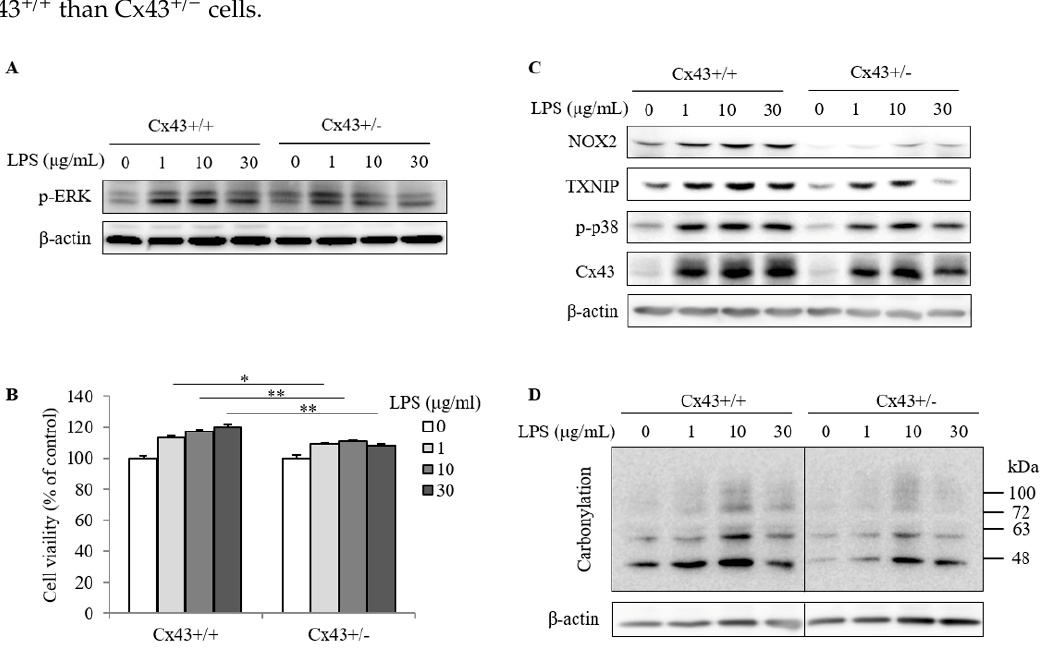
Figure 4. Responses of Cx43 +/+ and Cx43 +/ − spleen cells to LPS-induced changes in proliferation and redox status. ( A , B ) Different cell responses to LPS-induced ERK activation and cell proliferation. Spleen cells isolated from Cx43 +/+ and Cx43 +/ − mice were stimulated with the indicated concentrations of LPS for 24 h. Cell lysates were collected and detected for p-ERK using Western blot analysis ( A ). Cell proliferation after the stimulation was determined using WST assay ( B ). Data are expressed as the percentage of formazan formation against the untreated control (mean ± SE, n = 4). * p < 0.05, ** p < 0.01. ( C ) The response of Cx43 +/+ and Cx43 +/ − spleen cells to LPS-induced changes in intracellular oxidative status. Spleen cells were treated the same as above. The cellular proteins were harvested and subjected to Western blot analysis for NOX2, TXNIP, p-p38 and Cx43 ( C ), as well as protein carbonylation ( D ). Data in ( C ) were representative of three separate experiments with similar results.